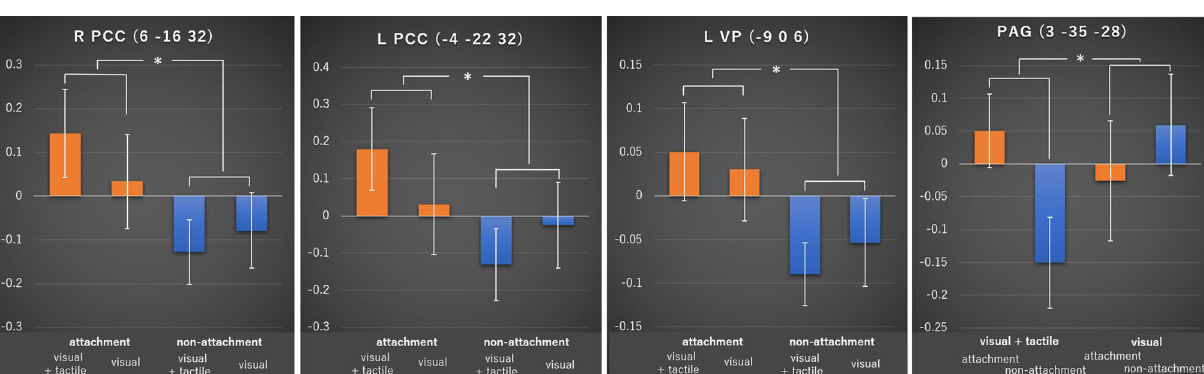
nectivity to this ROI (− 6, 0, − 14) in the interactive effect of attachment and touch (pFWE = 0.016 < 0.05, SVC) (Fig. 6). Multiple regression analyses showed that the individual strength of connectivity of the right PCC (6, − 16, 32) to the right anterior HC (36, 0, − 24) in the main effect of attachment positively correlated with “attach- ment” (df = 13, t = 2.150, p = 0.048; R 2 = 0.175; Durbin-Watson [D-W] statistic = 1.921; Kolmogorov–Smirnov test p = 0.200) (Fig. 5). In addition, the individual strength of connectivity between the left VP (− 9. 0, 6) and left TPJ (− 36, − 48, 28) in the main effect of attachment positively correlated with the DRN (6, − 32, − 24) activ- ity (df = 16, t = 2.845, p = 0.012; R 2 = 0.294; D-W statistic = 1.580; Kolmogorov–Smirnov test p = 0.200) (Fig. 4).